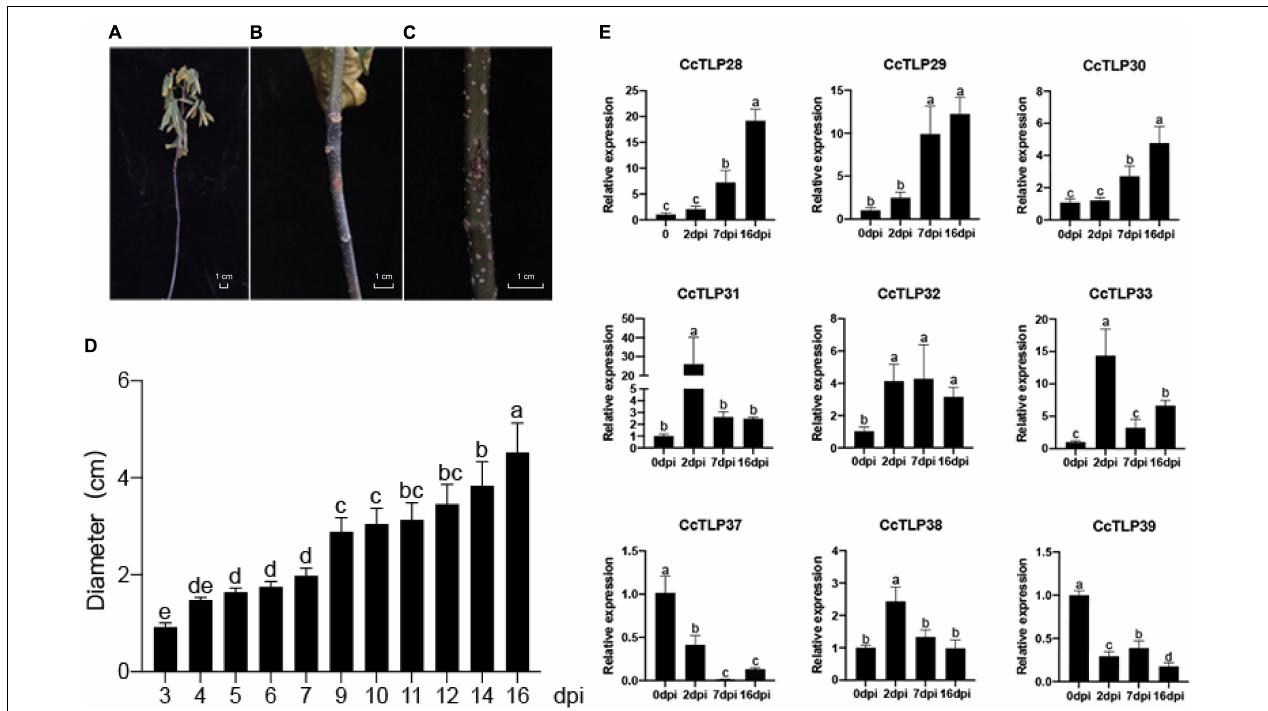
FIGURE 7 | The phenotype and expression analysis of CcTLP genes in response to Botryosphaeria dothidea infection. (A) Plant phenotype after 14 days after inoculation (dpi). The leaves were dried and curly. (B,C) The disease areas of wound sites were applied to agar containing B. dothidea mycelia and empty 0.5-cm-diameter agar, respectively, after 14 dpi. (D) Analysis of the diameter length of disease areas at 3, 4, 5, 6, 7, 9, 10, 11, 12, 14, and 16 dpi. This is represented by the mean ± SE. Error bars were obtained from three technical repeats. (E) An expression analysis of CcTLP family genes under B. dothidea infection. Samples were collected at 0, 2, 7, and 16 days after treatment. Each bar is the mean ± SE from three technical repeats. Different letters in the error bar showed significant differences between the sample groups as determined using ANOVA (Duncan’s test, p <